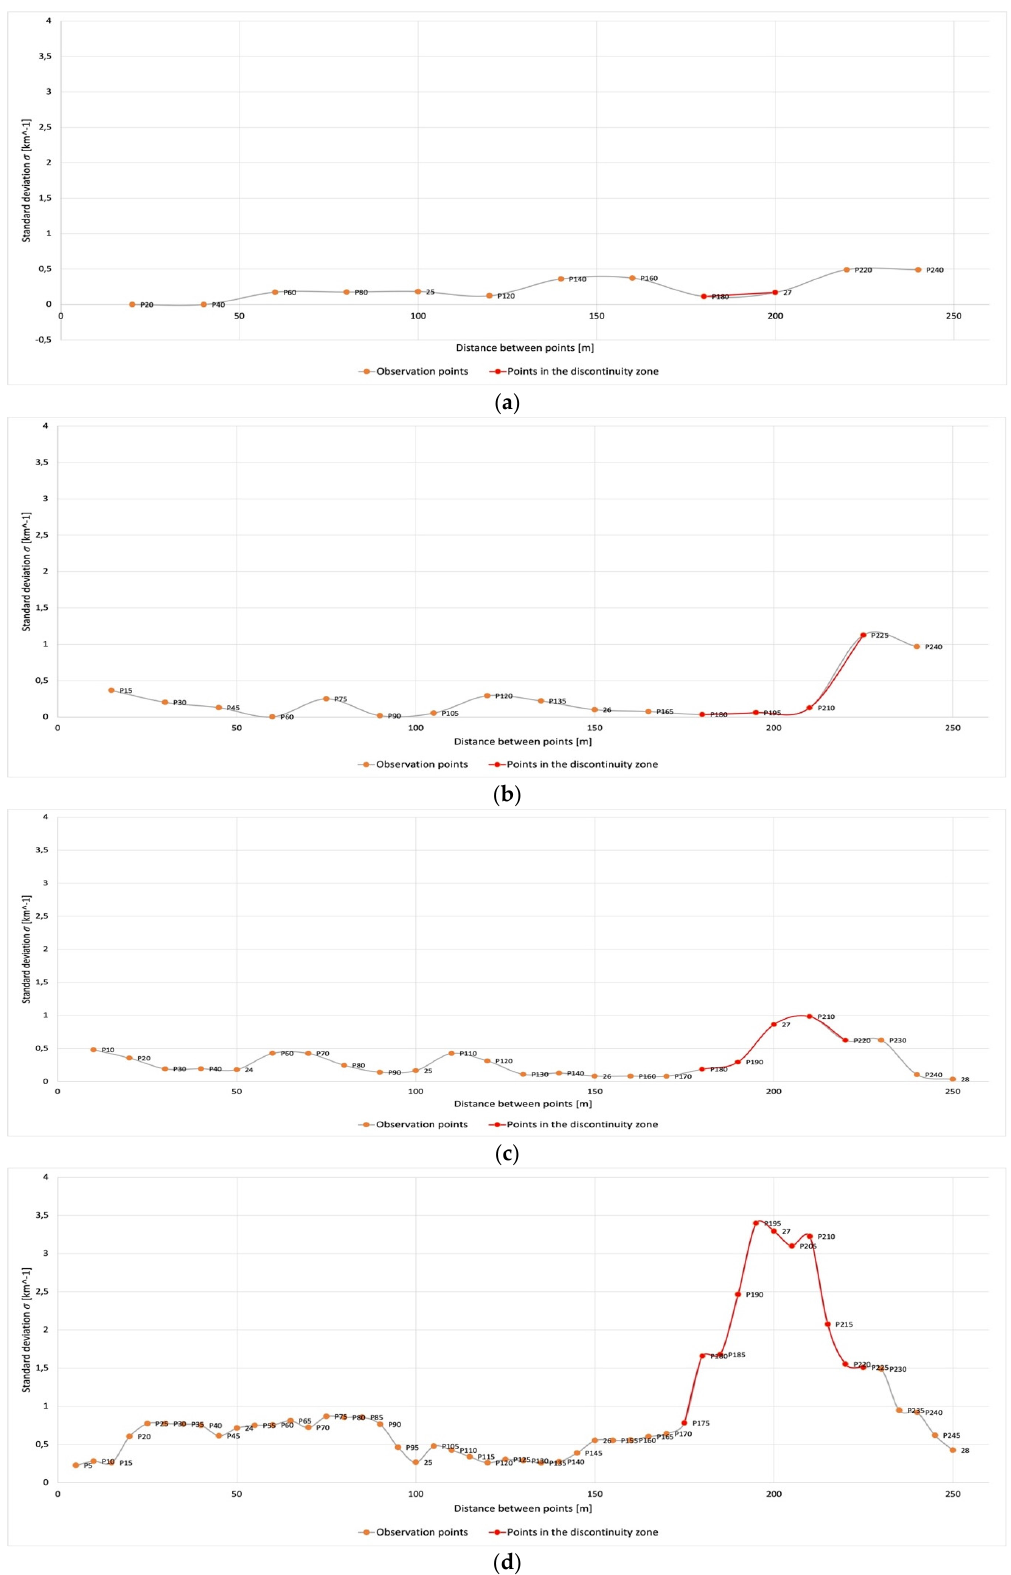
Figure 20. Standard deviation ( σ ) graphs for measurement points at a distance of ( a ) 20 m, ( b ) 15 m, ( c ) 10 m and ( d ) 5